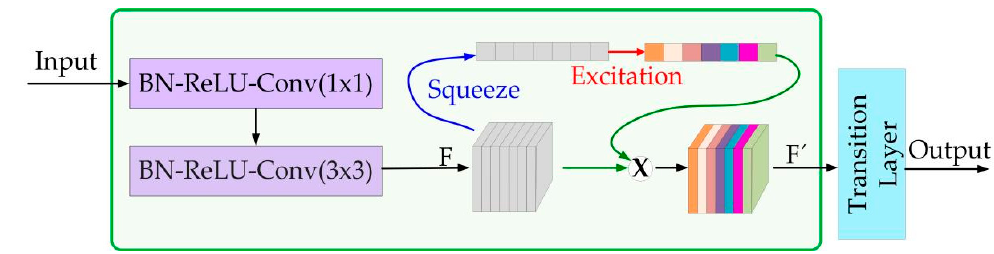
Figure 9. SE-dense block structure.